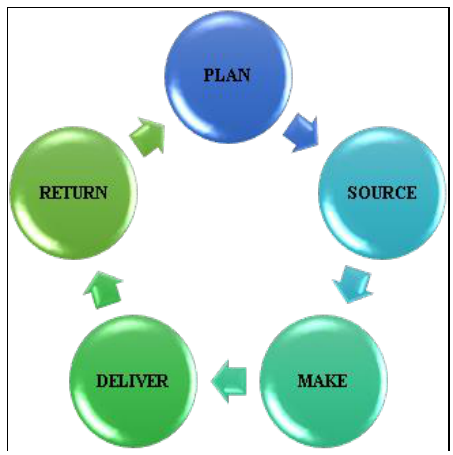
Figure.4. Supply Chain Operation Reference Model Source: